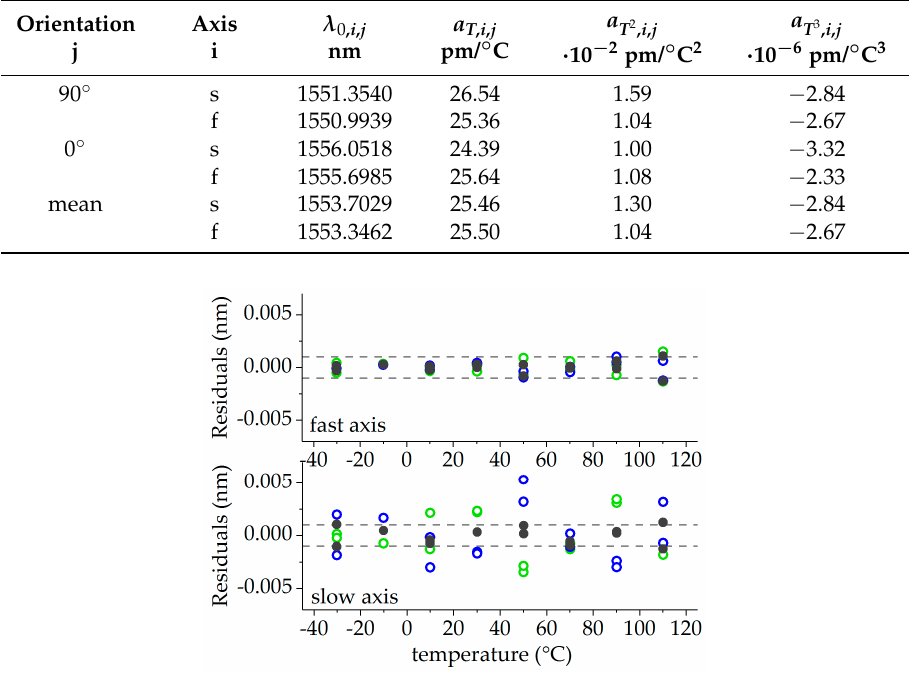
Figure 9. Residuals of the temperature calibration: FBG in the 0 ◦ -orientation in green, FBG in the 90 ◦ -orientation in blue, and mean values in grey. Table 2. Fitting parameters of the temperature calibration of the PM tandem.